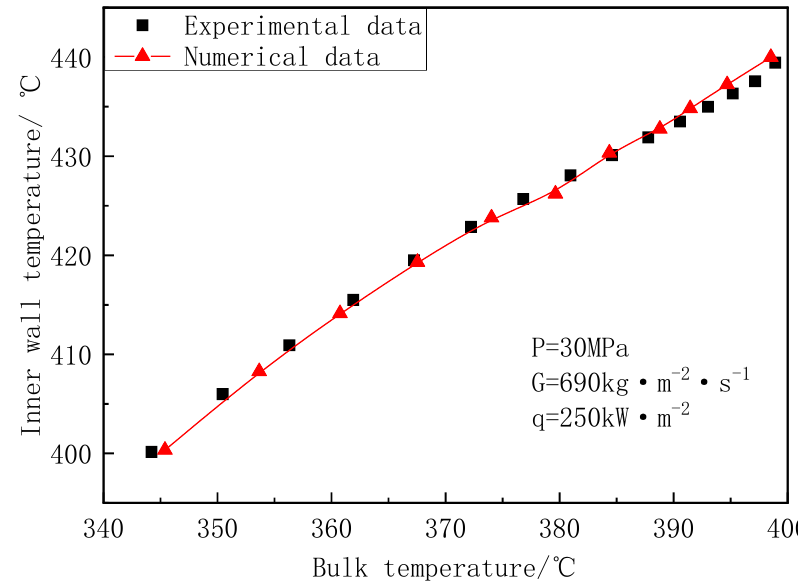
Figure 7. Comparison between the experimental data and numerical data.